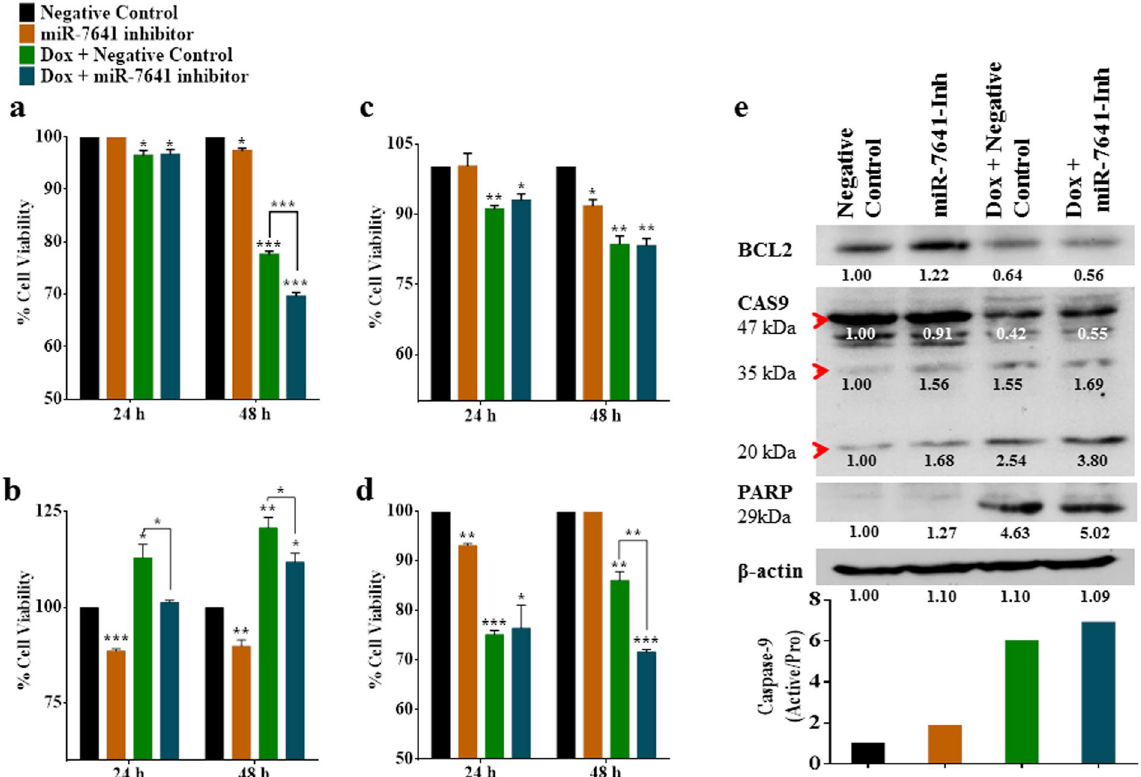
Figure 3. Inhibition of miR-7641 reduced the viability of cancer cells and enhanced the efficiency of doxorubicin treatment. ( a ) As shown in bar diagram, inhibition of miR-7641 reduced the viability of MCF-7 breast cancer cells, and a treatment strategy using both doxorubicin and the miR-7641-inhibitor was significantly ( p < 0.001) more effective than doxorubicin plus the negative control treatment. ( b ) Bar diagram showing that the miR-7641-inhibitor could sensitize MDA-MB-231 breast cancer cells. Treatment with both doxorubicin and the miR-7641-inhibitor reduced cell viability significantly ( p < 0.05) compared with the doxorubicin plus negative control group. ( c ) As shown in the bar diagram, the miR-7641-inhibitor reduced viability of HT-29 colon cancer cells significantly ( p < 0.05) at 48 h post-transfection. However, there was no significant difference between the doxorubicin plus miR-7641-inhibitor group and the doxorubicin plus negative control group. ( d ) Bar diagram showing that the miR-7641-inhibitor could sensitize HCT116 colon cancer cells, and that doxorubicin plus miR-7641-inhibitor treatment was significantly ( p < 0.01) more effective than doxorubicin and negative control treatment. ( e ) Western blotting analysis showing that doxorubicin plus the miR-7641-inhibitor treatment was more effective in enhancing the upregulation of apoptotic molecules, such as CAS9 and PARP, and downregulation of anti-apoptotic molecule BCL2 in MCF-7 breast cancer cells compared with the doxorubicin and negative control treated group. Bar diagrams show the mean ± SD obtained from triplicate experiments. * p < 0.05, ** p < 0.01, and *** p <